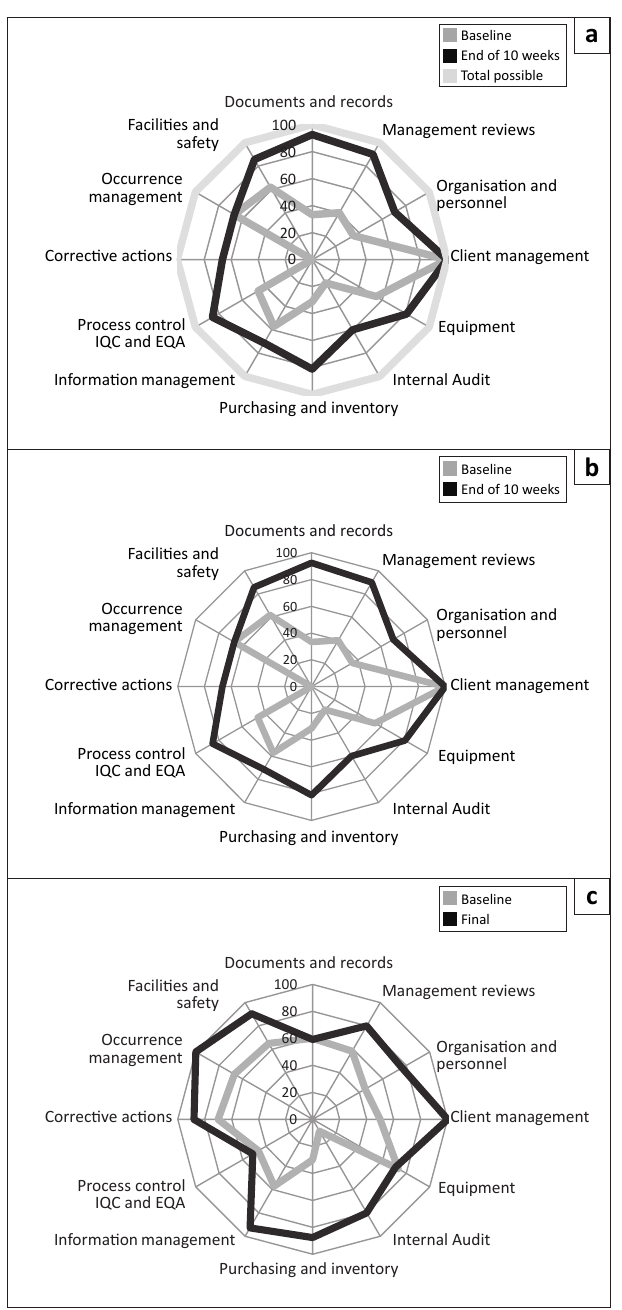
FIGURE 3: Performance of (a) Mafeteng District Laboratory, (b) Motebang District Laboratory and (c) Scott District Laboratory on the 12 sections of the SLIPTA checklist over 10 weeks of